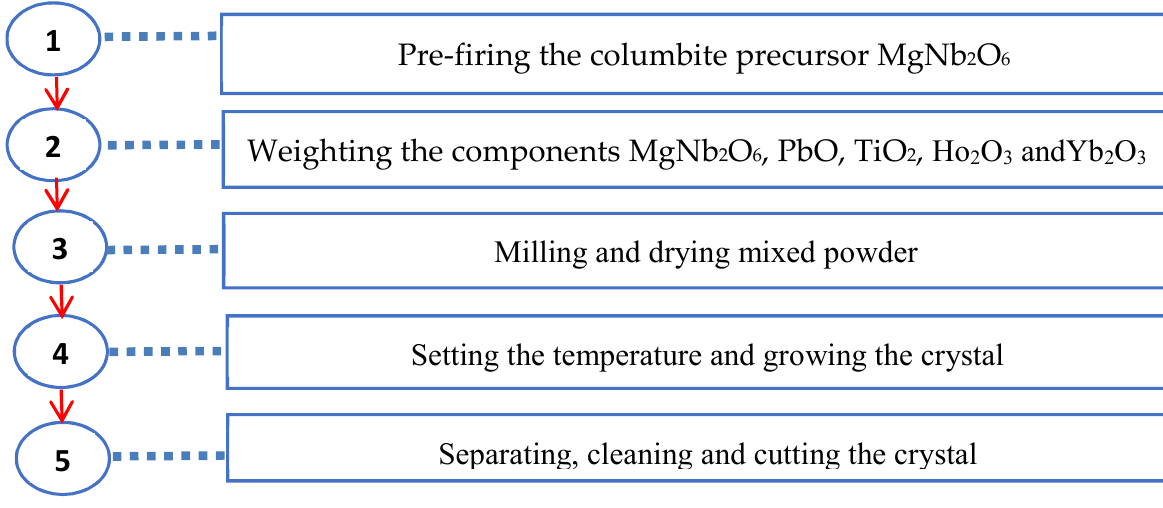
Figure 1. The steps of PMN-32PT:Ho 3+ /Yb 3+ crystal growth.